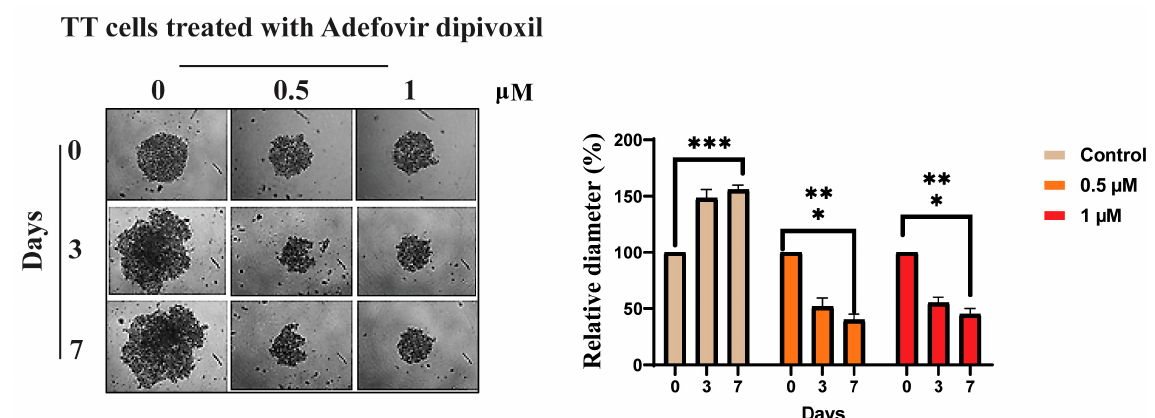
Figure 11 . Effects of adefovir dipivoxil on spheroid formation. Spheroids were formed by planting approximately 7000 cells and allowing them to grow for two days before treating them with adefovir dipivoxil. The treatment with adefovir dipivoxil began on day 0 after the initial two-day growth period. Images were taken of spheroids treated with 0, 0.5, and 1 µ M of adefovir dipivoxil and their growth and reduction were tracked over a 7-days period. The relative diameter of the spheroids was measured using ImageJ and the results showed a statistically significant effect of adefovir dipivoxil on spheroid growth (* p < 0.05, ** p < 0.01 and *** p < 0.001).